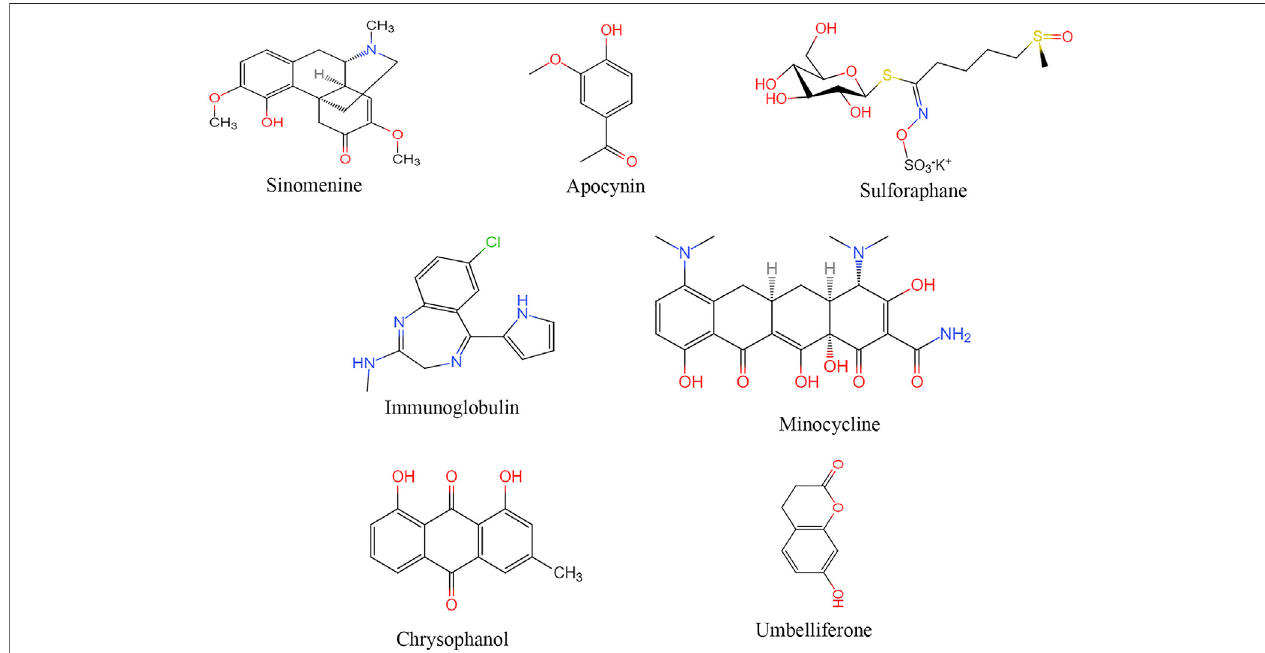
FIGURE 3 | Structural of drugs targeting NLRP3 for treatment ischemic